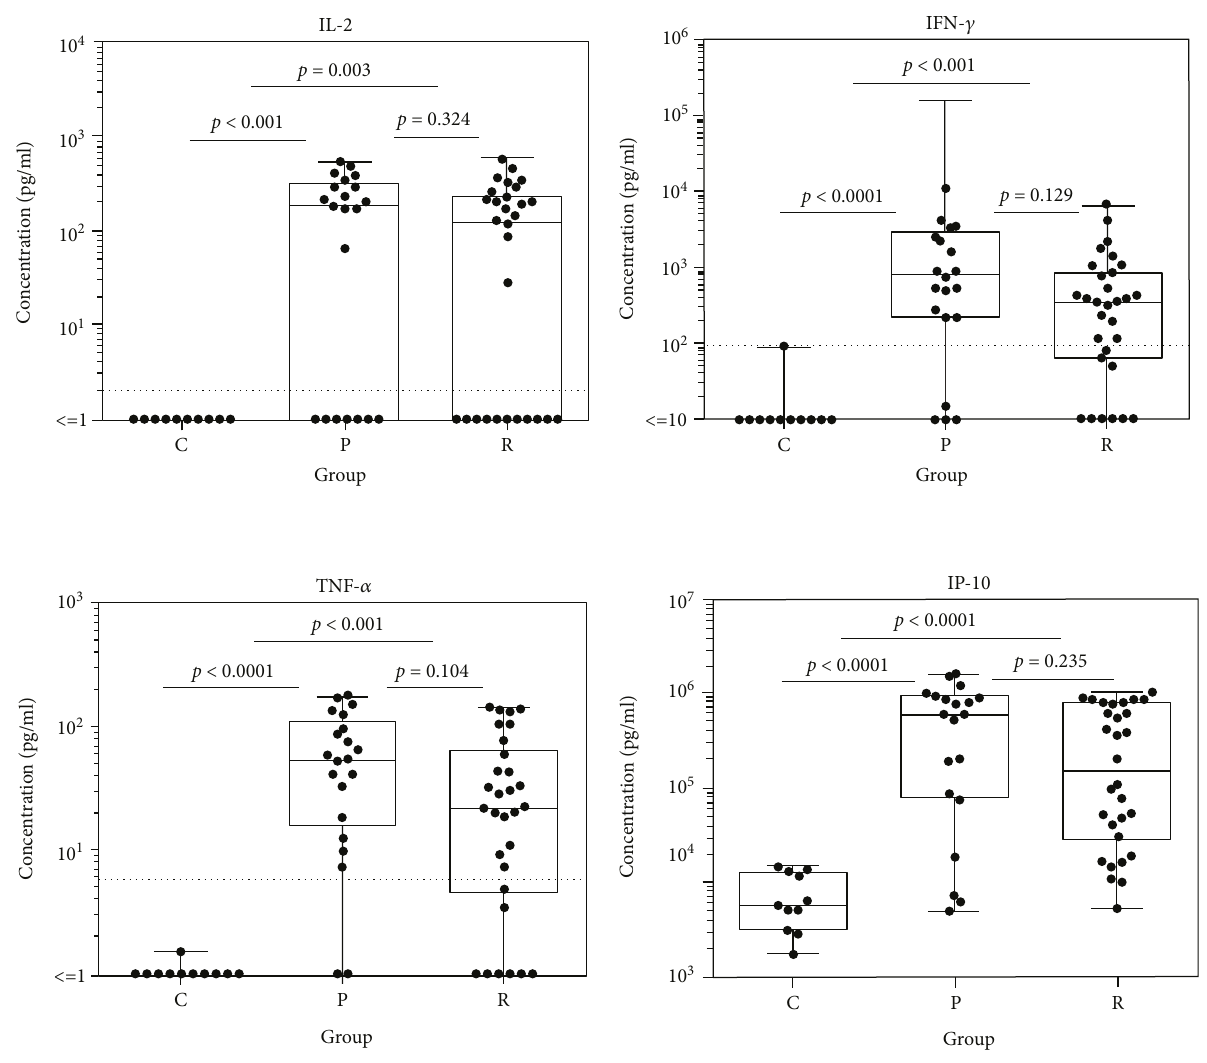
Figure 1: Box plot depicting the pro fi le of the T cell development-promoting cytokine IL-2 and T the chemokine IP-10 in aqueous humor of patients with pOT ( n = 21 ) and rOT ( n = 30 ) and the control group ( n = 11